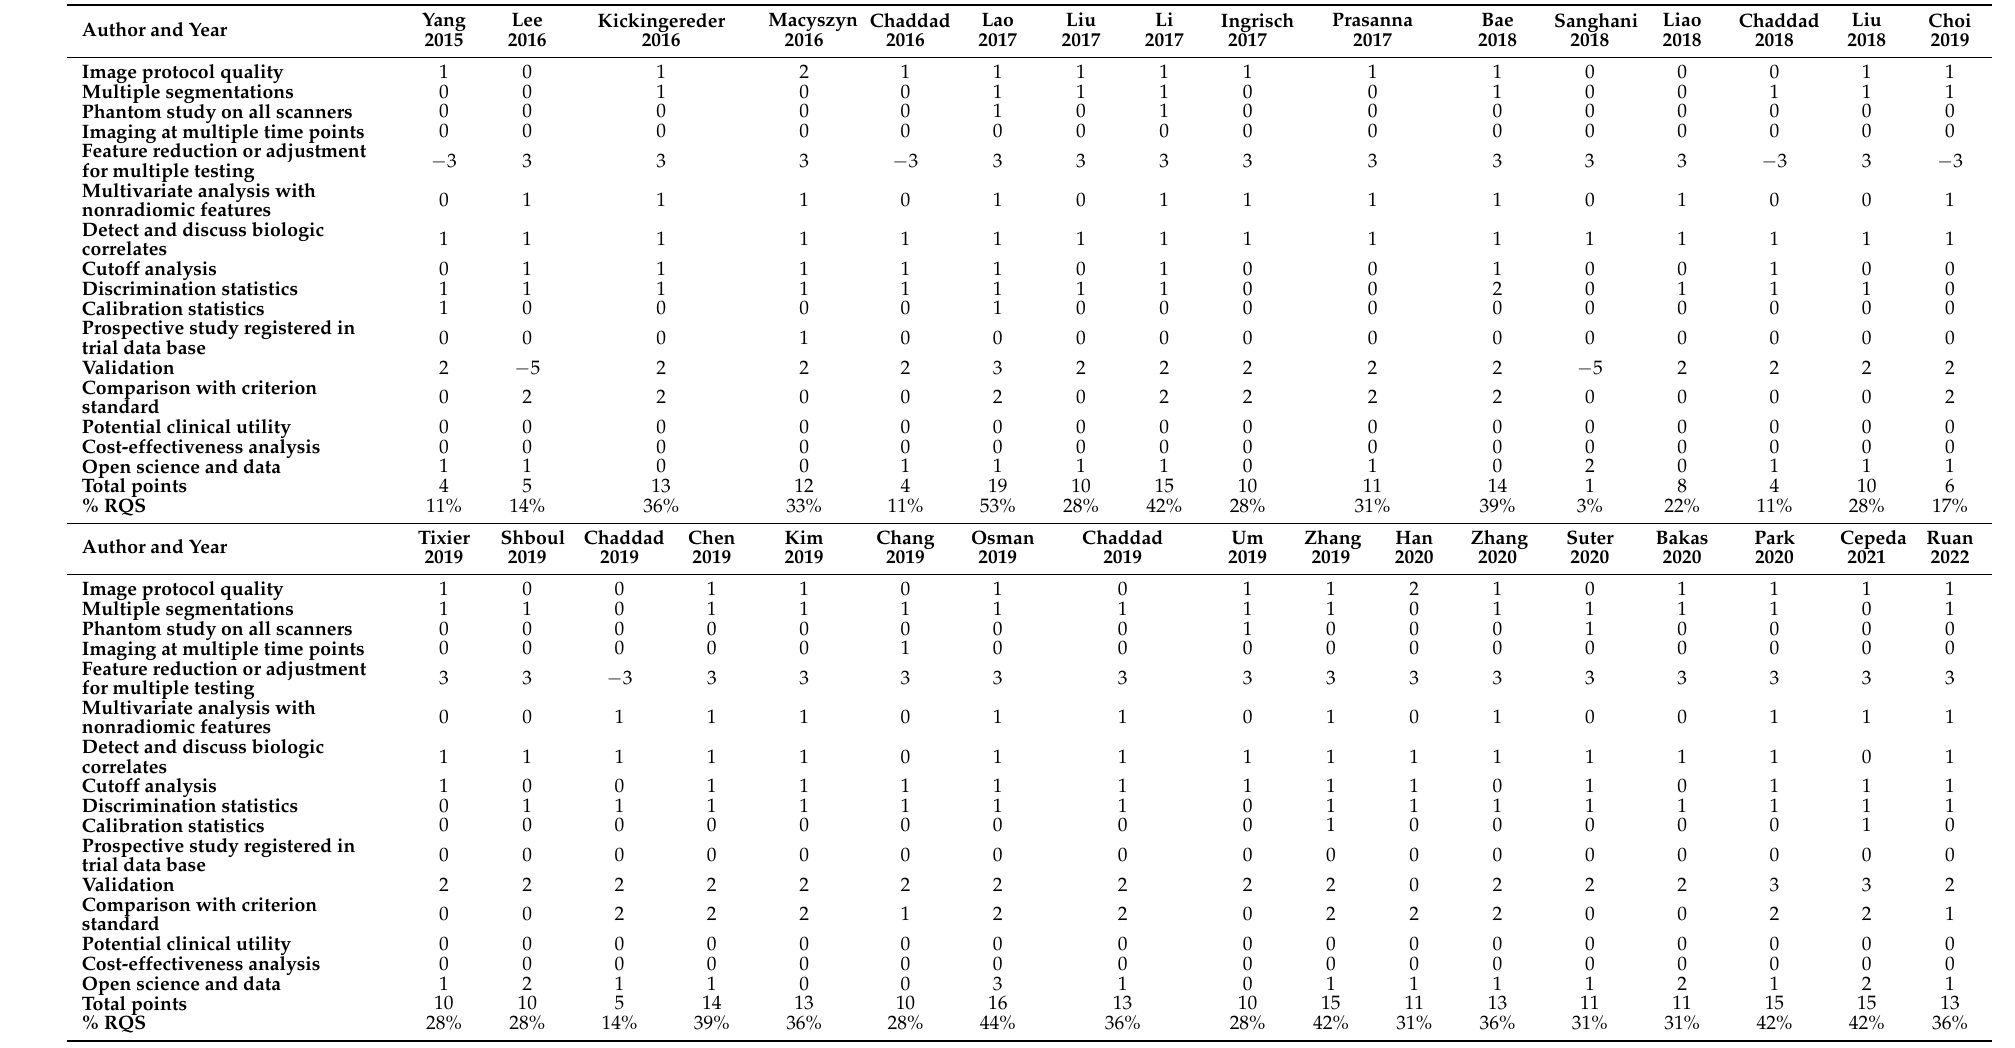
Table 2. Itemized score for the Radiomics Quality Score of the included radiomics studies assessing survival prognosis in high grade